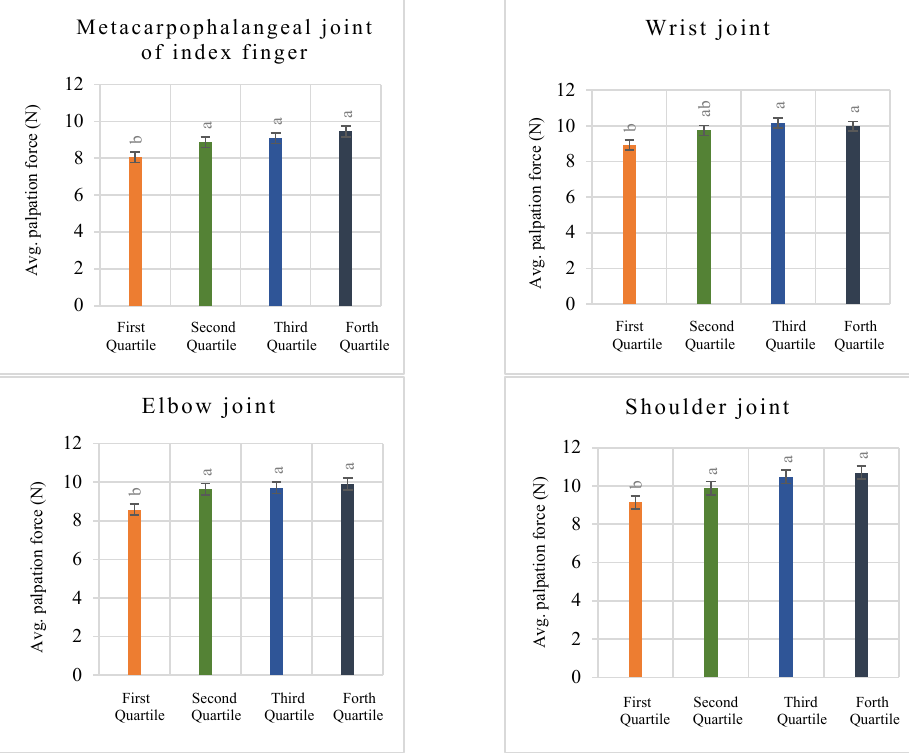
Figure 11. Average palpation forces applied on standard stiffness side in quarterly subsets of the total number of trials (mean ± standard error). Means labeled without a common letter are significantly different ( p < 0.05).